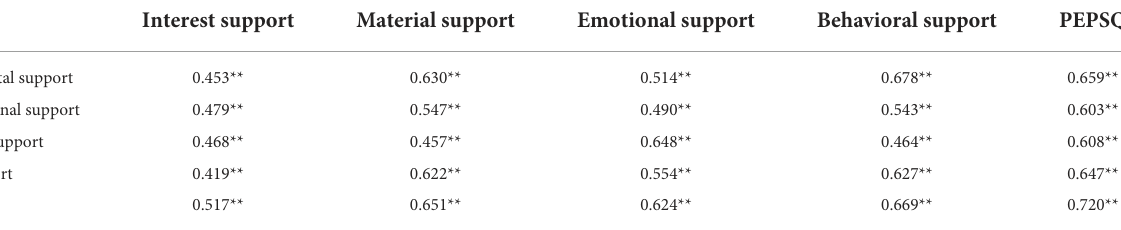
TABLE 10 Correlation analysis results.